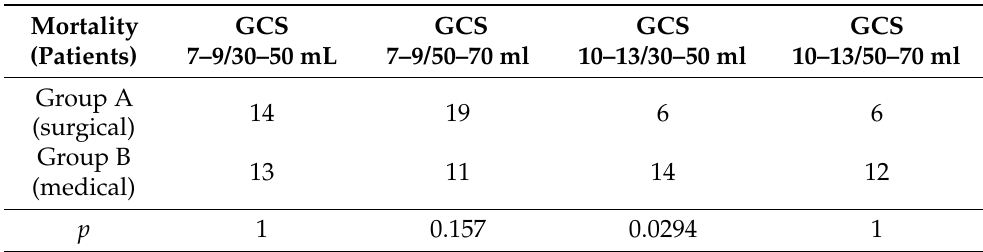
Table 3. Relationship between mortality, admission Glasgow Coma Scale (GCS) and intracerebral hemorrhage (ICH)